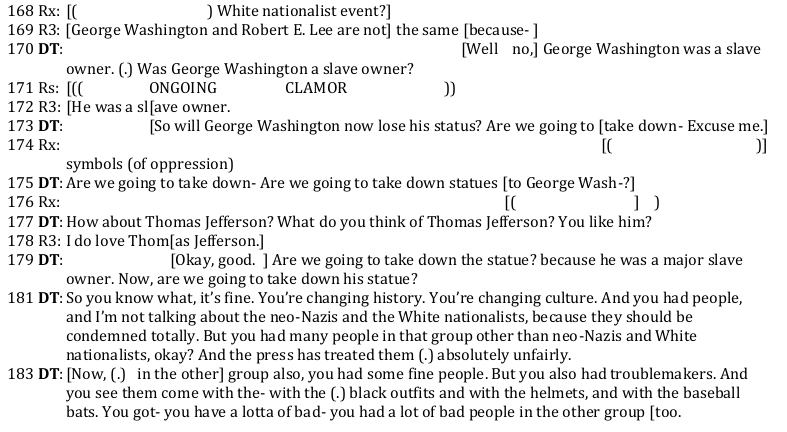
Figure 16. Transcript excerpt 168–183.